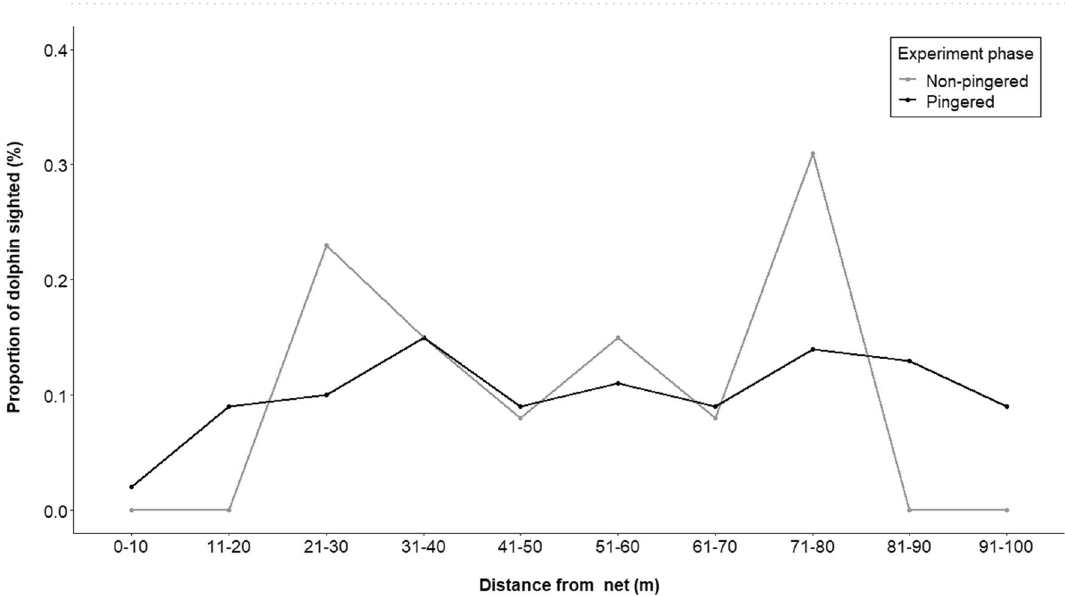
Figure 9. Proportion of calves sighted by visual observers during the pingered and non-pingered phases of the experiment at different distance